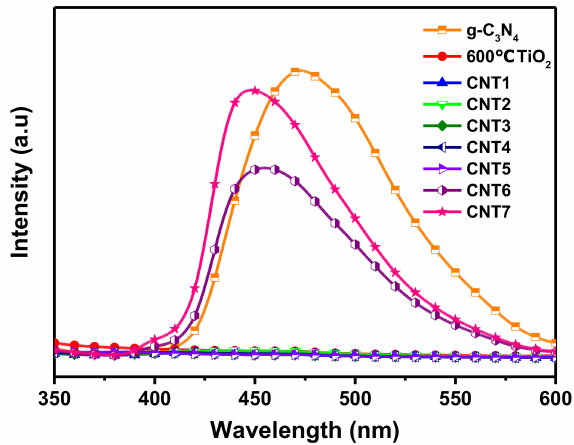
Figure 7. PL spectra of TiO 2 nanofibers and various CNT